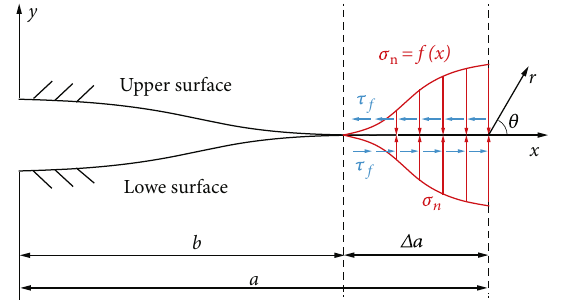
Figure 6: The stress mode of the closed region at the crack